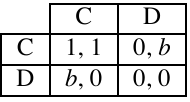
Table 1. Payoff matrix of the Prisoner’s Dilemma game.